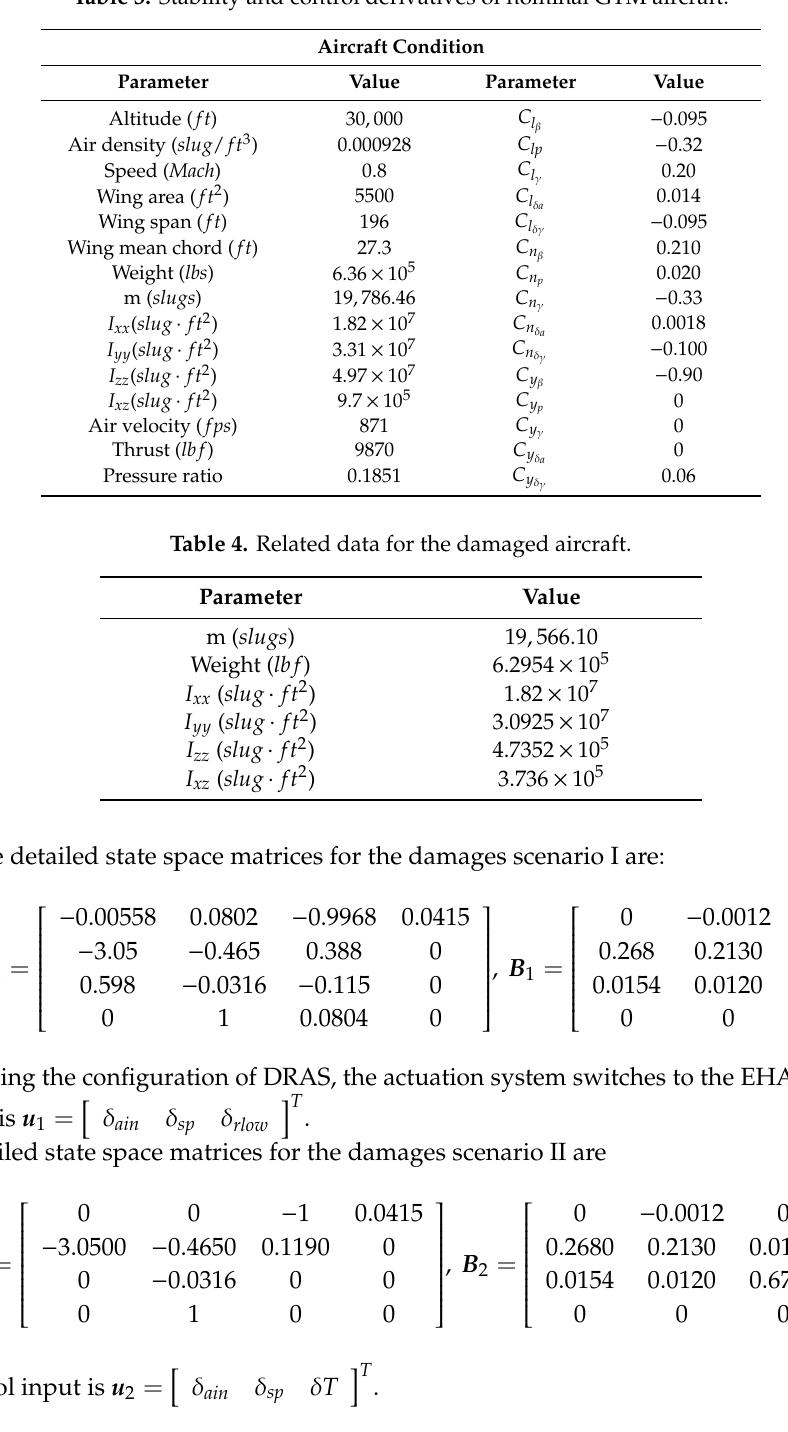
Table 3. Stability and control derivatives of nominal GTM aircraft.